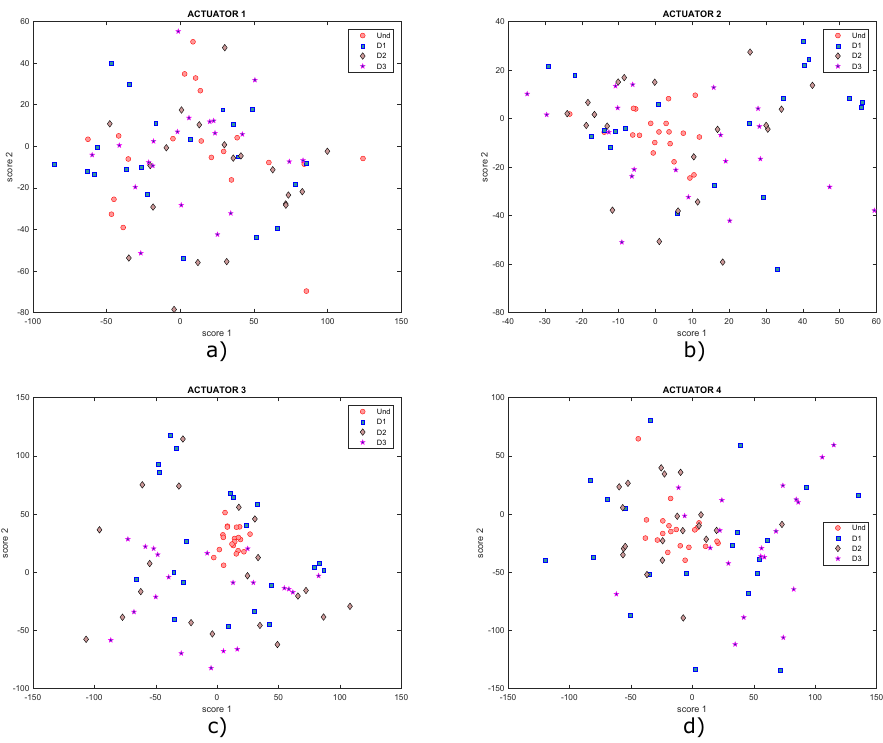
Figure 20. Graphs of score 1 vs. score 2 for actuation phases: ( a ) 1; ( b ) 2; ( c ) 3 and ( d ) 4.